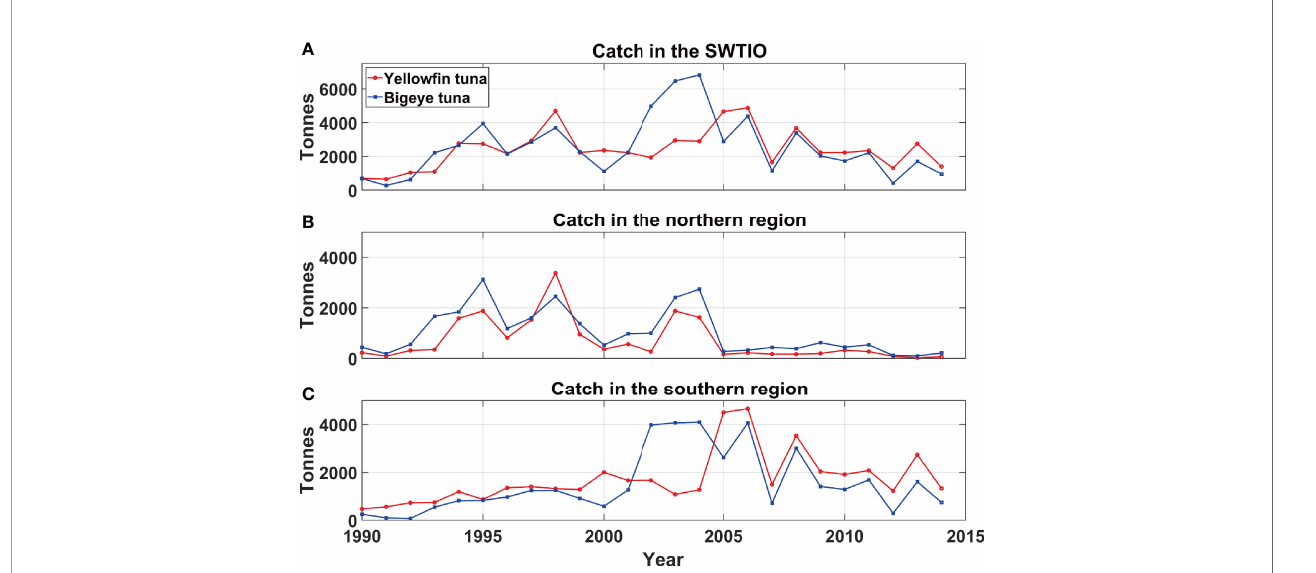
FIGURE 3 | (A) The annual catch amounts of yellow fi n tuna and bigeye tuna during 1990 – 2014 in the four exclusive economic zones (EEZs) of the entire SWTIO. (B) The same as (A) , but only for the northern region of the SWTIO (the Republic of Seychelles). (C) The same as (B) , but only for the southern region of the SWTIO (the Republic of Mauritius, Tromelin Island, and Reunion